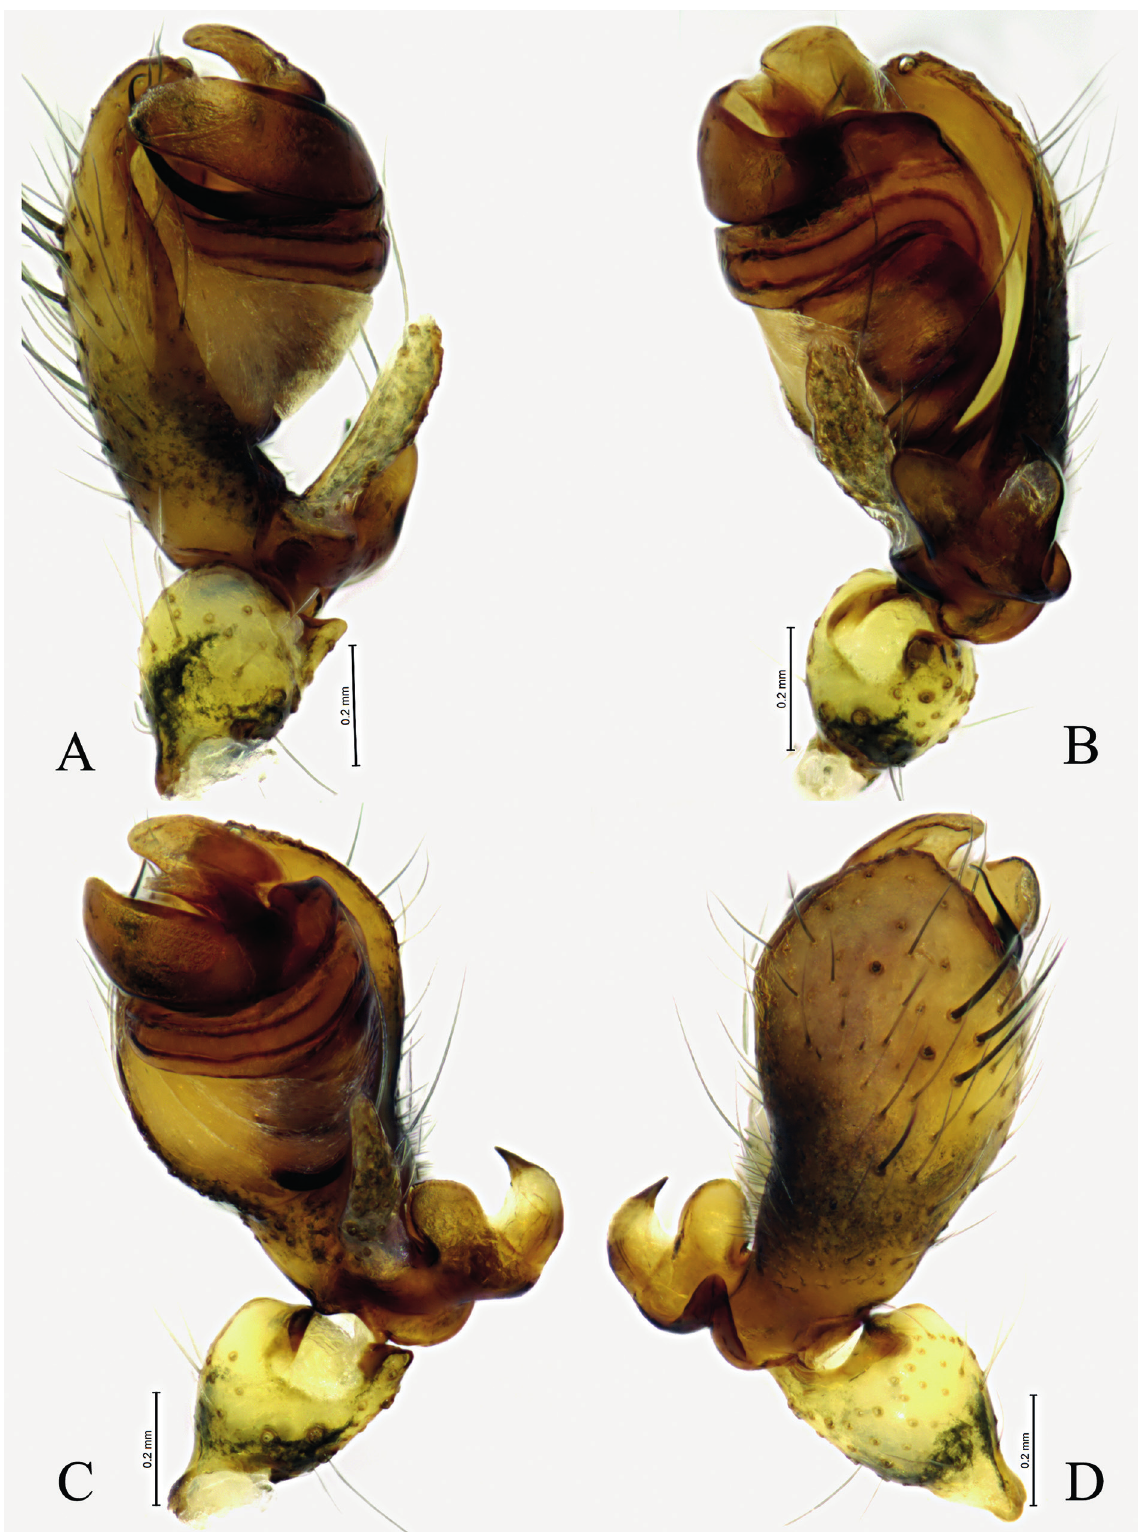
Fig. 11. Meta hongyuan sp. nov., ♂, holotype (SWUC-T-TEg-05-01). A . Left palp, prolateral view. B . Same, ventral view. C . Same, retrolateral view. D . Same, dorsal